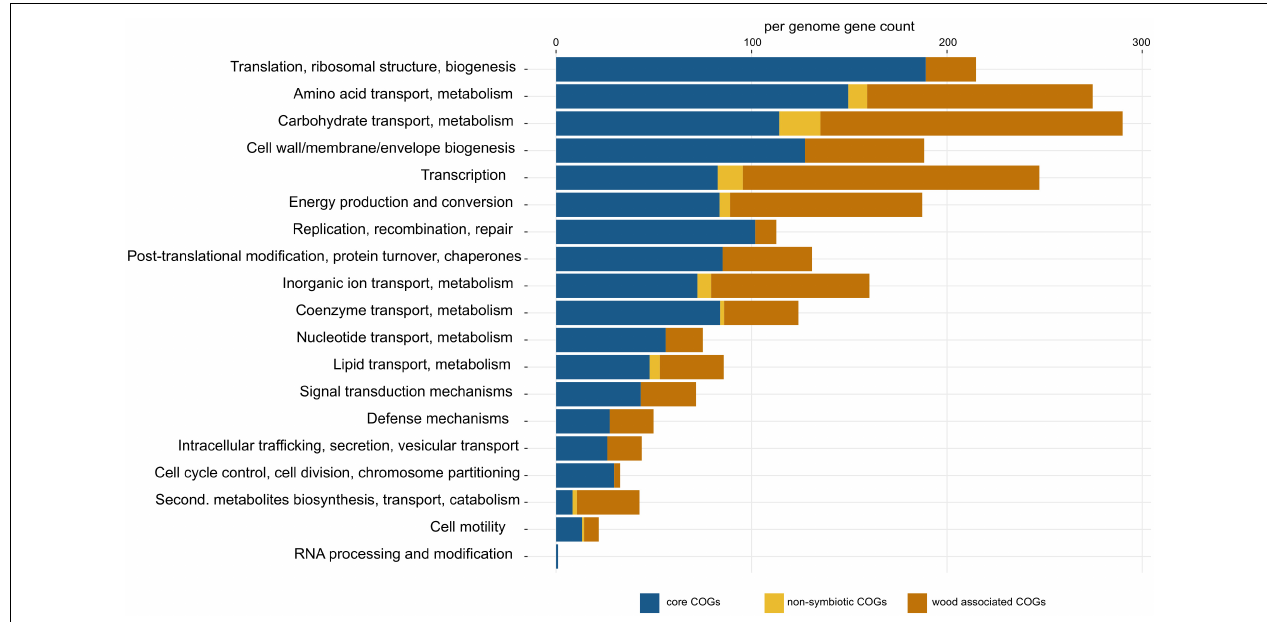
FIGURE 2 | Detailed list of COG functions in Sodalis core genes (blue), non-symbiotic life-associated accessory genes (yellow) and wood-associated accessory genes (orange). Gene counts were corrected for the number of genomes in each group (core = 11, free-living = 4, wood-associated = 3). Per-genome numbers of additional genes with unknown function are not displayed, and their counts are: core = 403, free-living = 42, wood-associated =